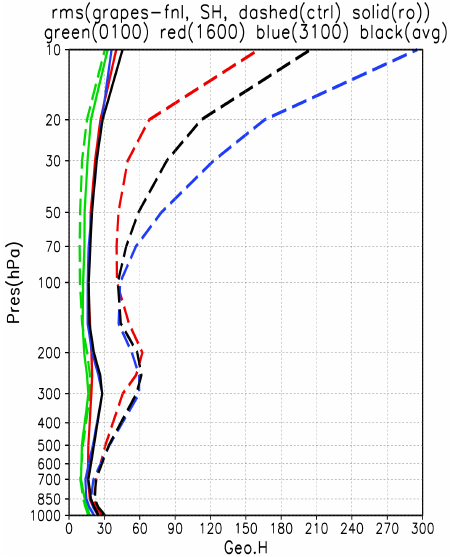
Figure 8. RMSE of geopotential height analysis between GRAPES and NCEP (GRAPES minus NCEP) in the Southern Hemisphere for the control (dashed line) and the RO (solid line) experiment. Green, red and blue lines are the RMSE in the initial time, 15th and 30th day, respectively; the black lines are the monthly average RMSE.